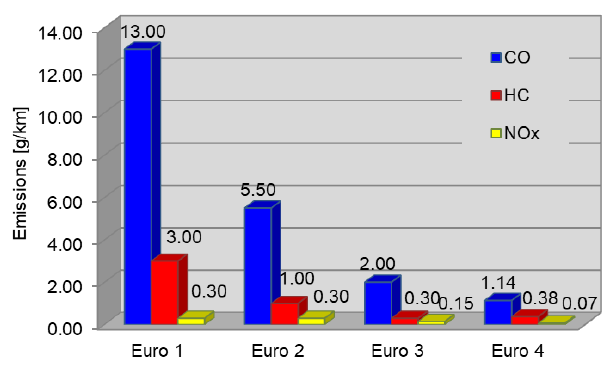
Fig. 3. The exhaust emission limits for motorcycles (category L3e)